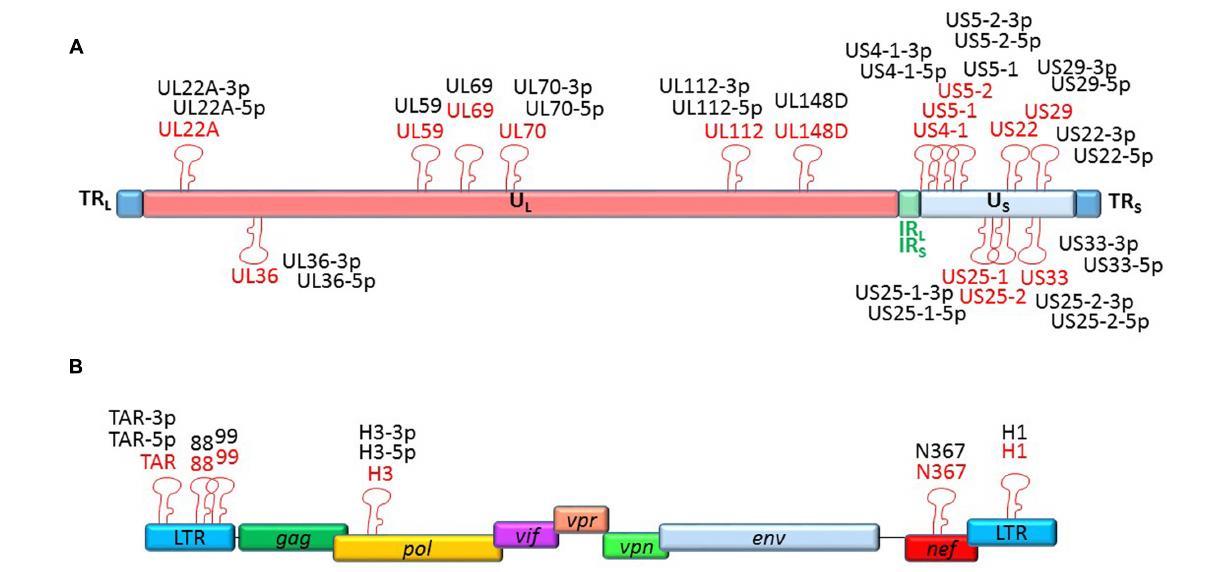
Frontiers in Microbiology |